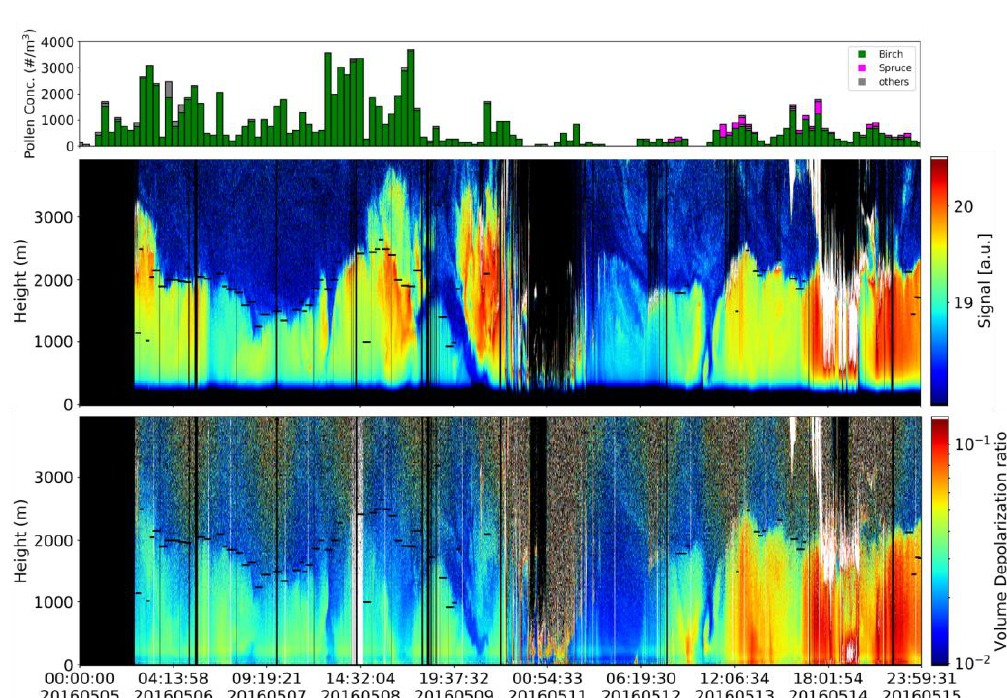
Figure 1 Overview of the 11 days intense birch pollination period. Upper panel: pollen concentration measured with Hirst-type air sampler. Center panel: Range-corrected lidar signal at 1064 nm. Lower panel: Volume depolarization ratio at 532 nm. Black lines indicate top height of the layers used for pollen